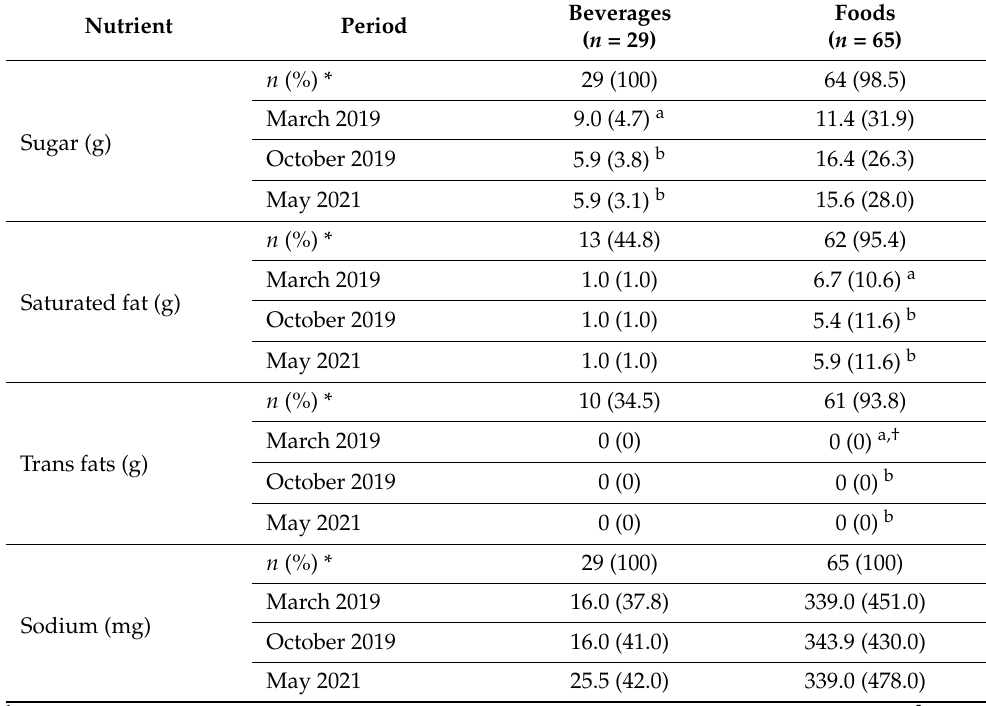
Table 2. Nutrients of concern per 100 g/mL in processed and ultra-processed products across time 1,2 . Nutrient